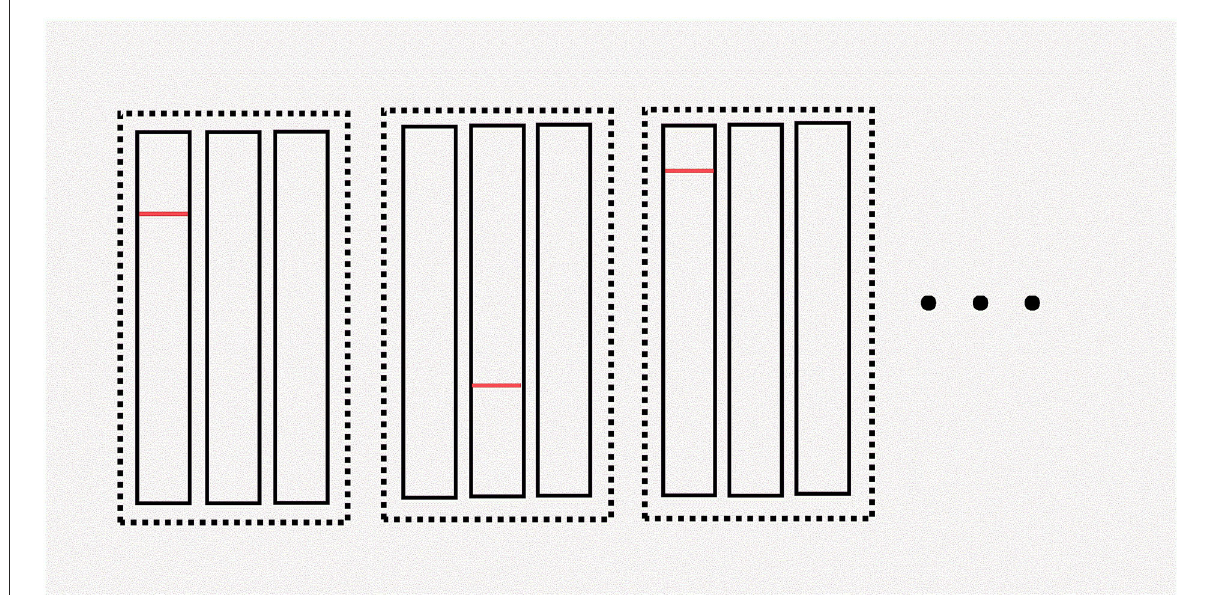
FIGURE2 Illustration of hypercube pooling. The “dimension” is the total number of dotted rectangles. The “edge” is the number of rectangles within each dotted rectangle. The red line in this figure denotes a positive sample. In this example, the first pool in the first group, the second pool in the second group, and the first pool in the third group are all positive. We can determine which patient is positive during this round of pooling by using the hypercube pooling strategy. For more details about hypercube pooling, the readers can refer to previous literature (36,